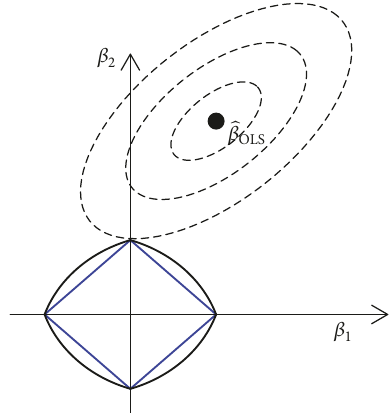
Figure 1: Two-dimensional LASSO penalty (blue) and Enet penalty ̂ 𝛽 (black). (𝑂𝐿𝑆) is the ordinary least squares solution and the contours ̂ 𝛽 reflect the estimates of with equal deviation in terms of squared error loss. Enet penalty is strictly convex, so the optimal solution is located in one corner of the